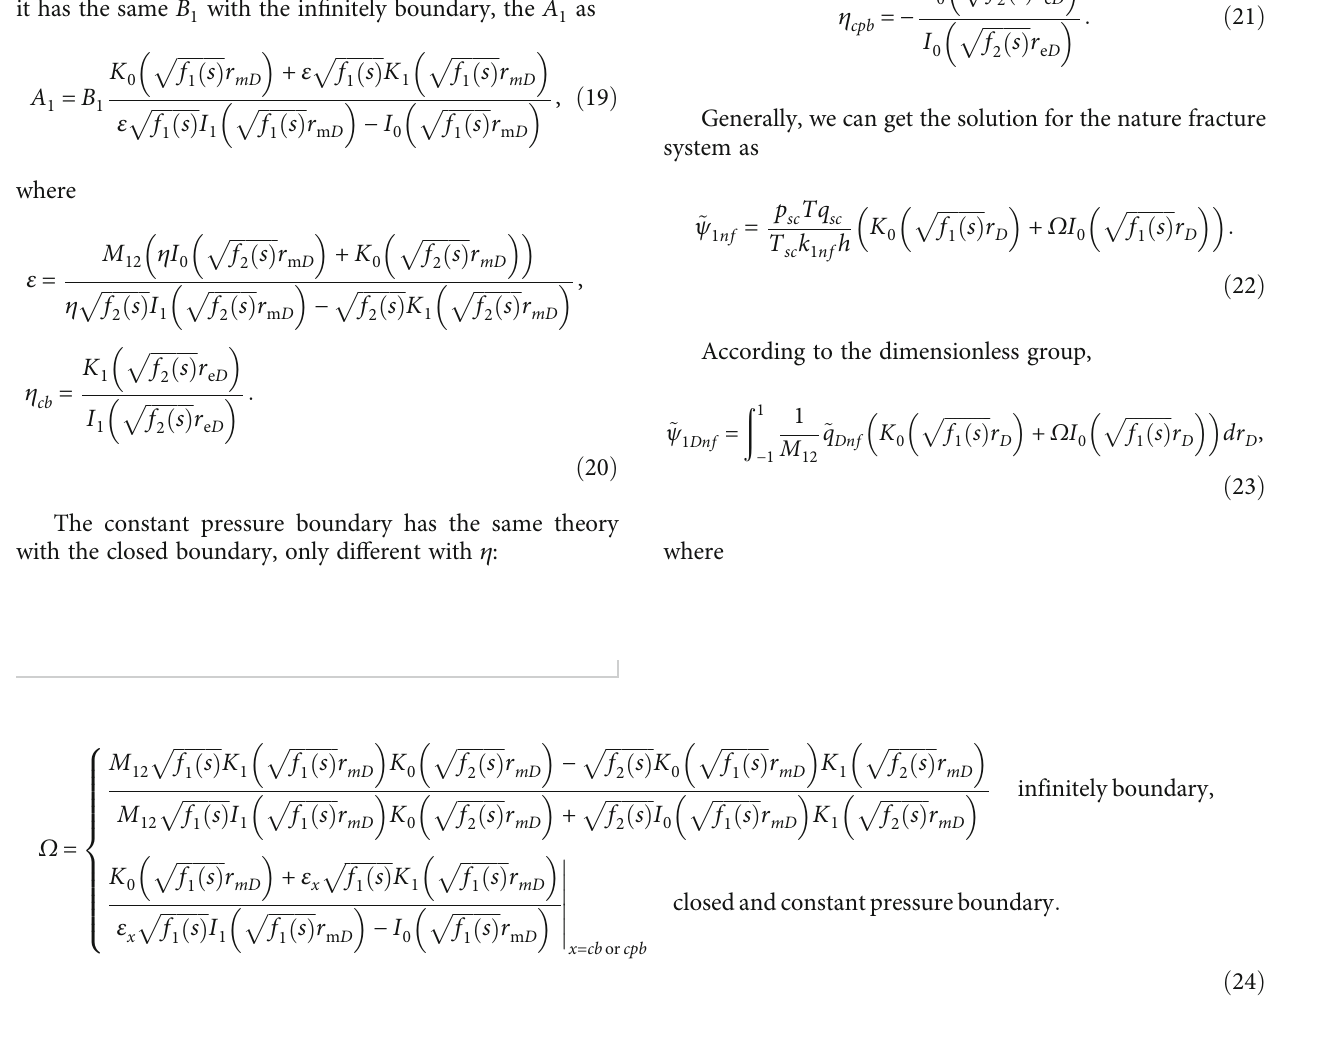
ffiffiffiffiffiffiffiffiffiffi